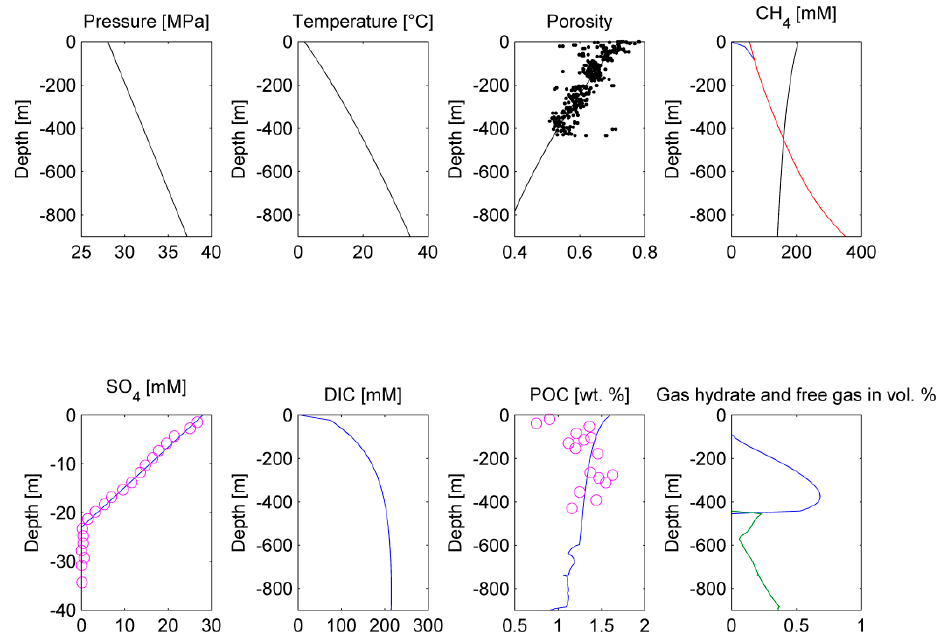
Figure 4. Modeling results of the Scenario 2a. Upper panel, from the left: Pressure, temperature, porosity, and dissolved CH 4 concentration plots. Porosity measurements [20] are depicted as black dots, the modeling solution is represented by the black line. On the CH 4 concentration plot, red line